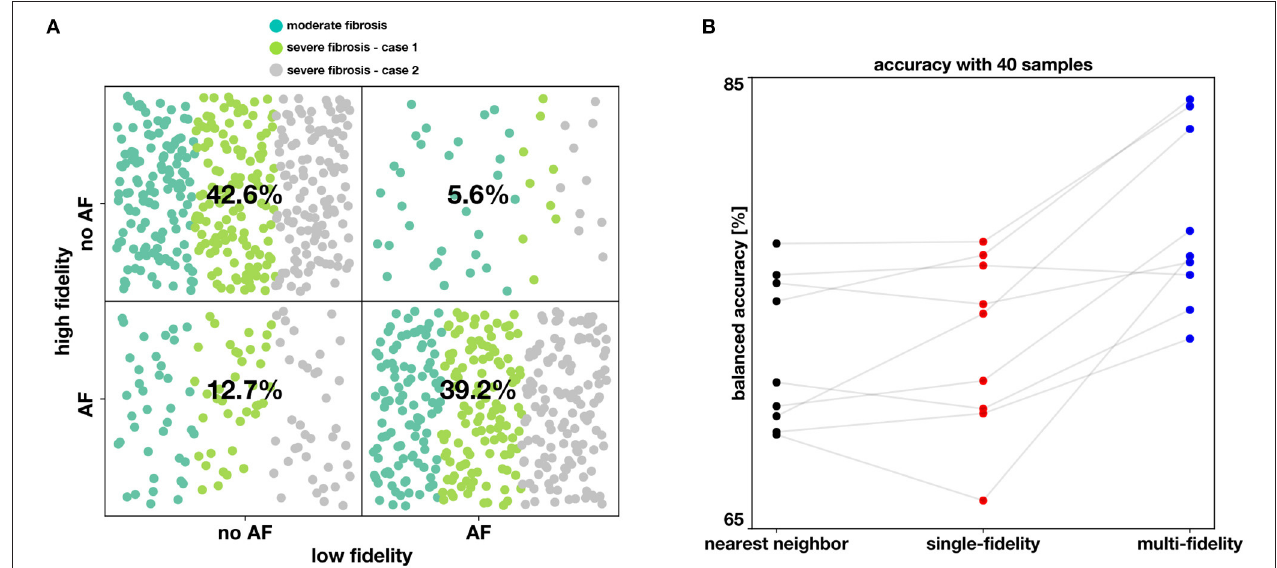
FIGURE 7 | Performance of the classifiers. In (A) , the agreement between the low fidelity and the high fidelity model is reported as a confusion matrix, as resulting from 1,800 simulations (900 per fidelity). Moreover, each point is colored according to the case of fibrosis. In (B) , we compare the balanced accuracy for the nearest neighbor, single-fidelity, and multi-fidelity classifier, for all nine model scenarios and with a fixed budget of 40 high fidelity simulations.